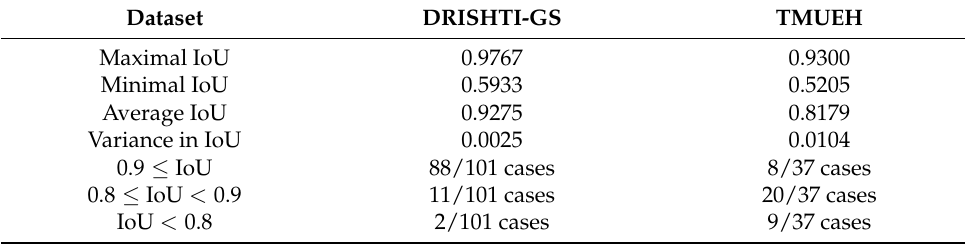
Figure 24. Segmentation result examples in TMUEH dataset (green contour: GT, blue contour: segmentation results) Table 4. Evaluation results with